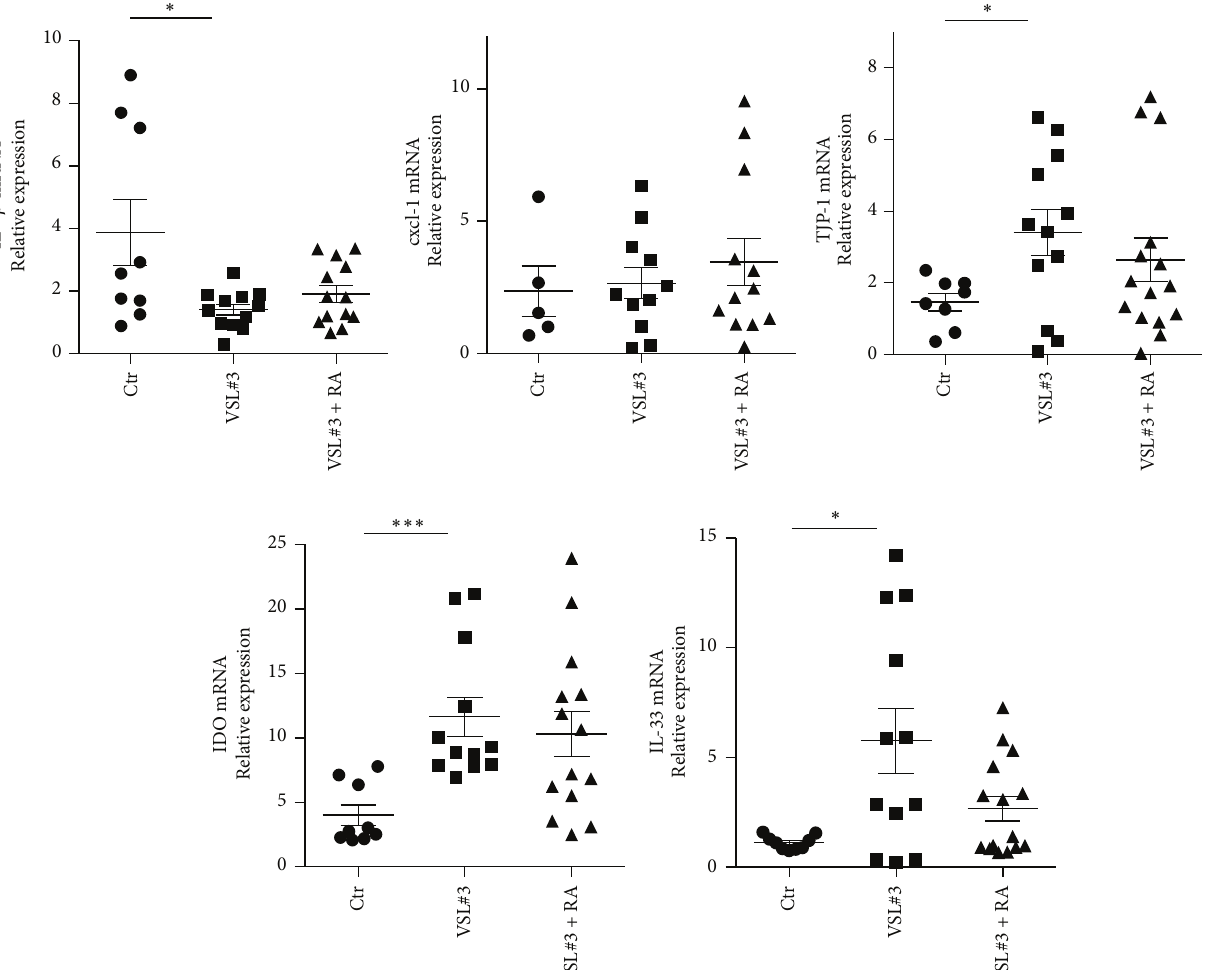
Figure 3: VSL#3 treatment halts intestinal inflammation and induces a protolerogenic intestinal environment. Intestinal mucosa tissues isolated from 12-week-old female NOD mice untreated ( 𝑛 = 9 ) or treated with VSL#3 alone (VSL#3; 𝑛 = 12 ) or in combination with RA (VSL#3 + RA). mRNA expression levels of the indicated cytokines and inflammasome components were measured by quantitative real-time PCR. Values represent the relative fold differences of the individual mice normalized against expression of a housekeeping gene ( Gapdh ). ∗∗∗ 𝑝 < 0.0005 , ∗ 𝑝 < 0.05 by Student’s 𝑡 -test. DCs of the VSL#3-treated and VSL#3 + RA-treated